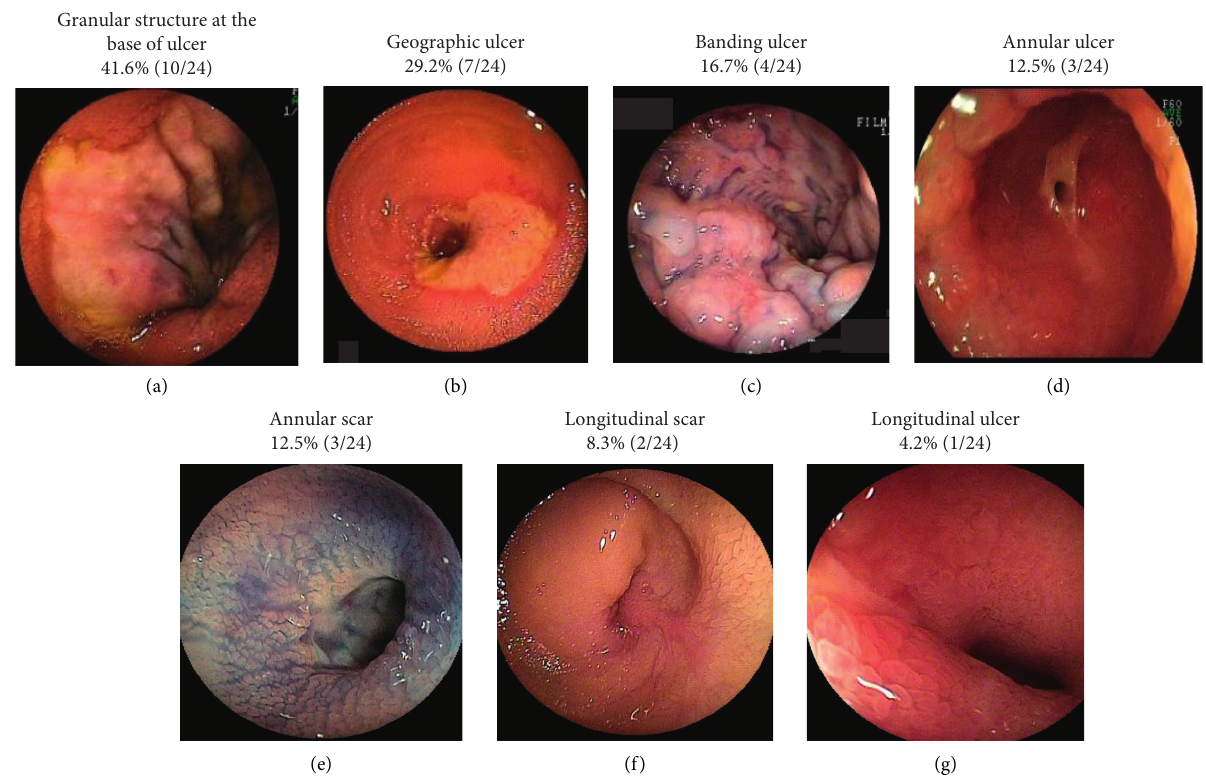
Figure 3: Endoscopic images from the stenosis site during the double-balloon